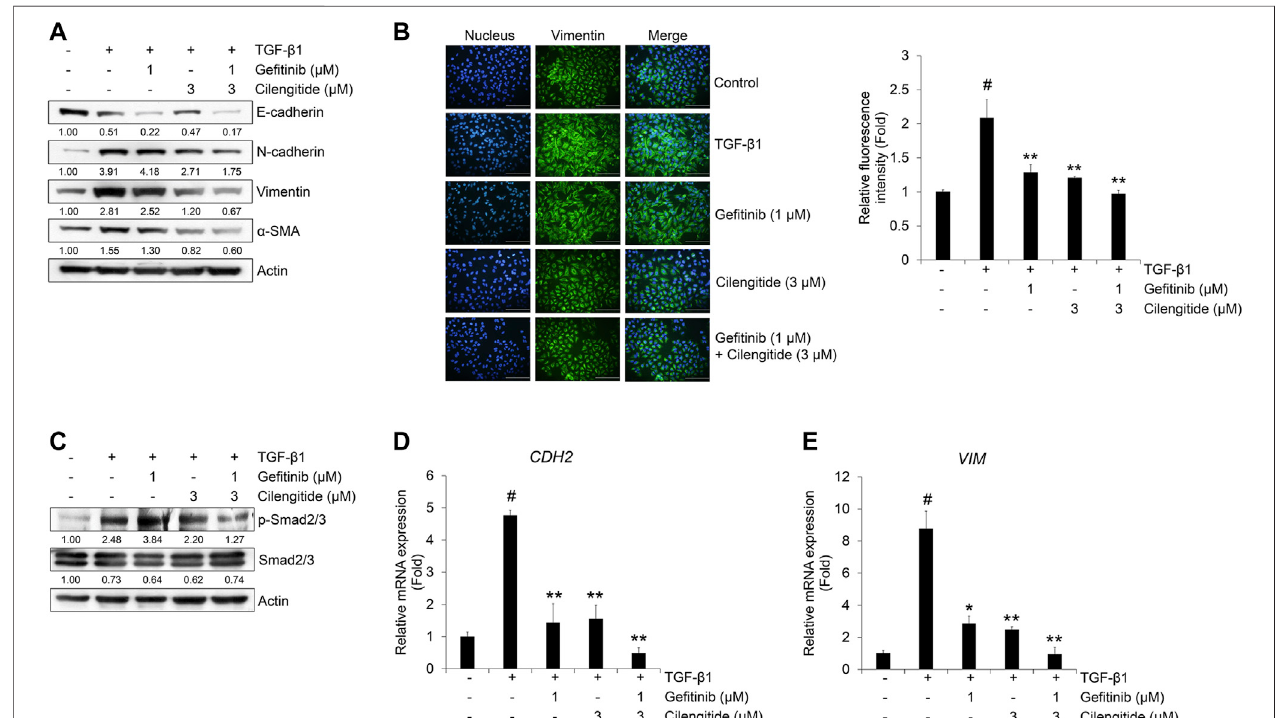
FIGURE 6 | Combination of ge fi tinib with cilengitide shows enhanced inhibitory effects on TGF- β 1-induced EMT expression and Smad signaling. A549 cells were treatedwithge fi tinib(1 μ M)andcilengitide(3 μ M)individuallyorincombination,andthenincubatedwithTGF- β 1(5 ng/ml)for72 h (A,B) or48 h (C) or24 h (D,E) .Theexpression of EMT markers (A) and phosphorylation of Smad2/3 (C) were measured by western blot analysis. Actin was used as a loading control. (B) The expression of vimentin was measured by immunocytochemistry. Nuclei were counterstained with DAPI. Scale bars (cid:2) 100 μ m. (D, E) After RNA extraction and cDNA synthesis, we performed qRT- PCRtomeasuretheexpressionofCDH2andVIMmRNAusingGAPDHasaninternalcontrol. # p < 0.01vs.control;* p < 0.05,** p < 0.01vs.thegrouptreatedwithTGF- β 1only.